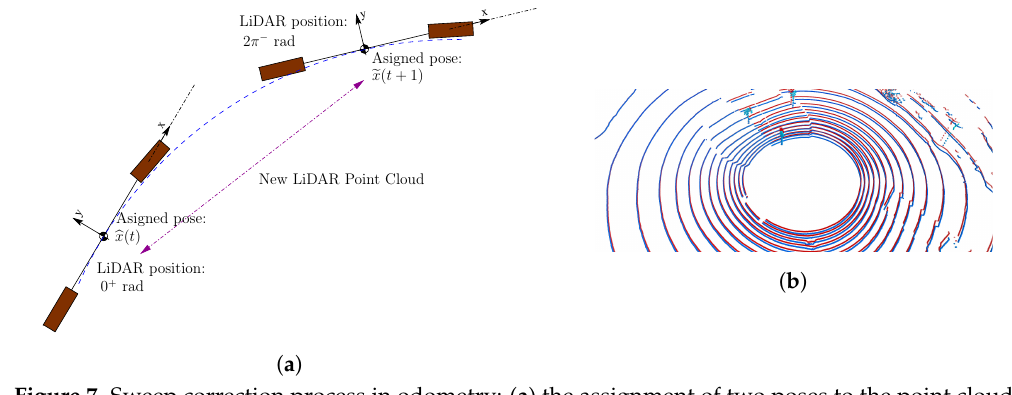
Figure 7. Sweep correction process in odometry: ( a ) the assignment of two poses to the point cloud when the vehicle is moving; and ( b ) raw (blue) and corrected measurements (red). An important difference between the measurement results of both point clouds is exposed, the correction being decisive for the result of the following